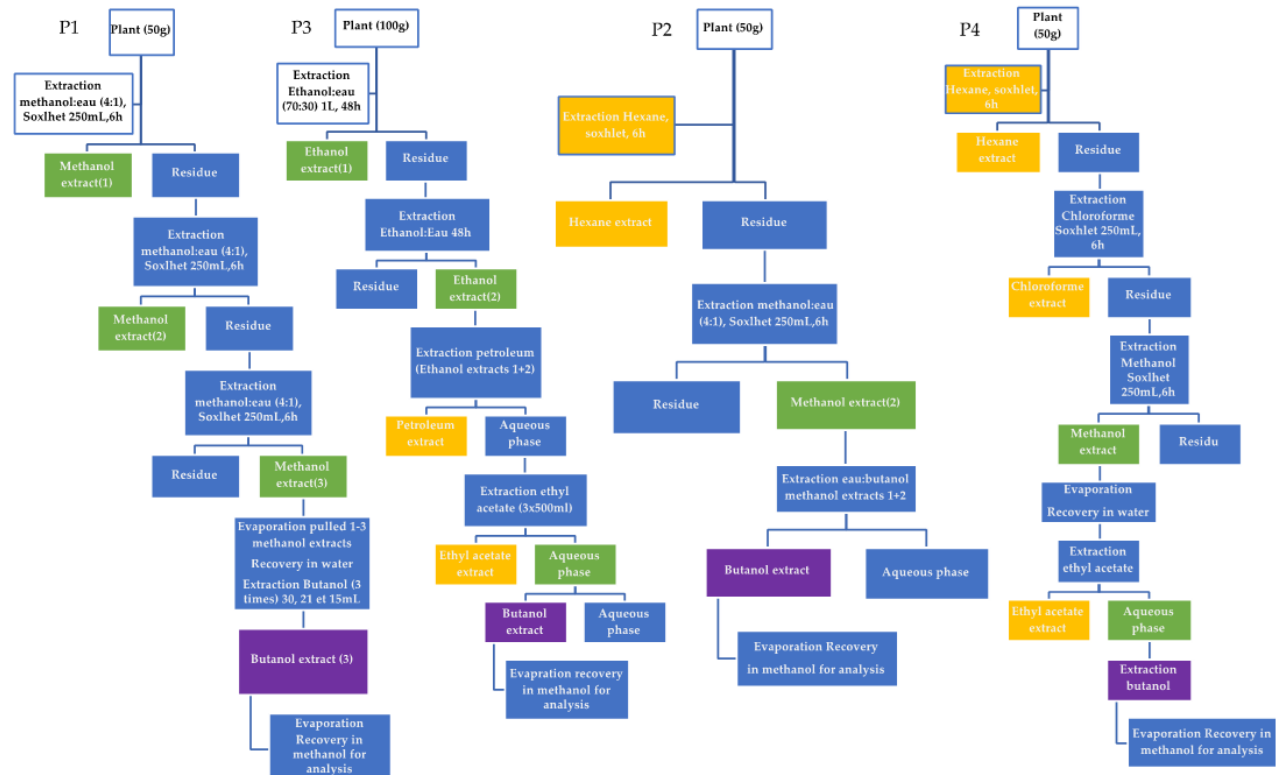
Figure 11. Diagrams of the extraction protocols from P1 to P4. Preliminary delipidation was carried out with hexane in the P2 and P4 protocols. out with hexane in the P2 and P4